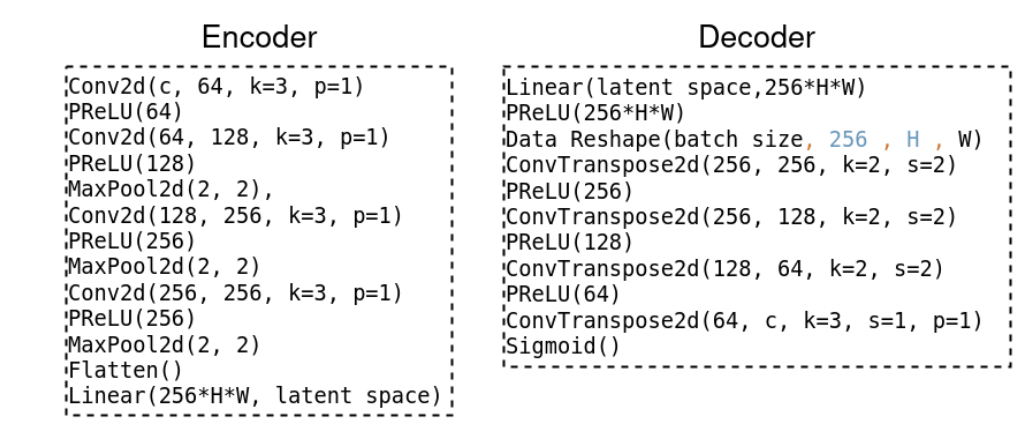
Figure 1. Overview of the architecture proposed for the spectral signals compression. c, k, p, and s are channels, kernel size, padding, and stride used, respectively. In the encoder block the stride is set up to 1. The latent space represents the data compression size of the last linear layer. This specific version model is applied over Lombardia Sentinel-2 dataset and little variations on the other dataset (see repository code [28] for